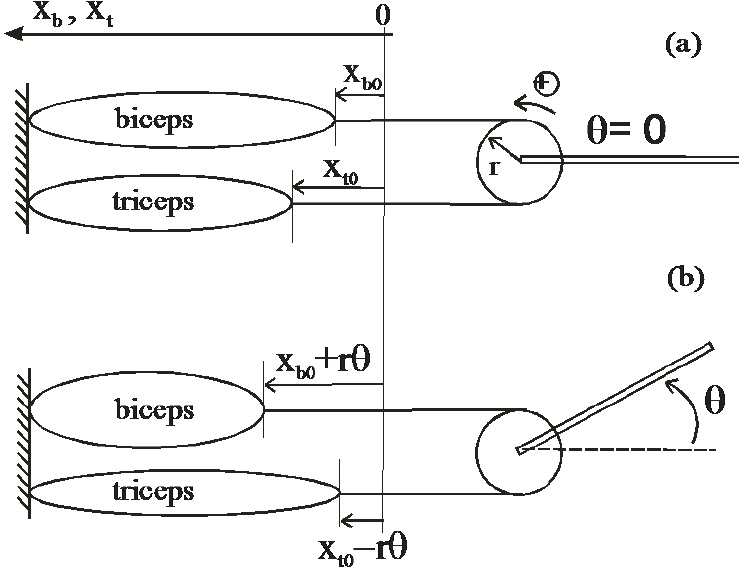
Figure 6. Constant moment arm antagonist actuator, ( a ) initial state, and ( b ) current